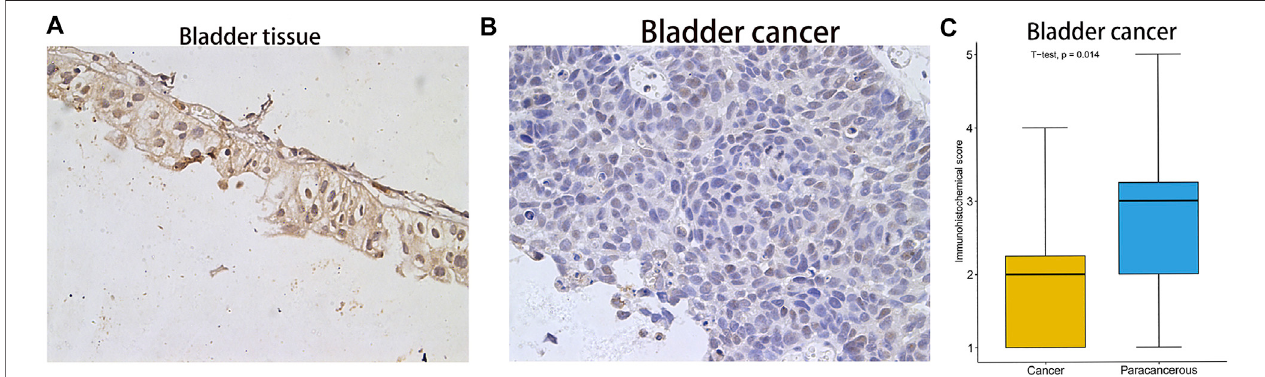
FIGURE5| Immunohistochemicalstainingresultsand statisticalplots of FAM46C protein expression innormal bladderand bladder cancertissues. (A) Represent 20× immunohistochemical image of bladder tissue. (B) Represent 20× immunohistochemical image of bladder cancer. (C) Statistical plots of FAM46C protein expression in bladder cancer and normal tissues.